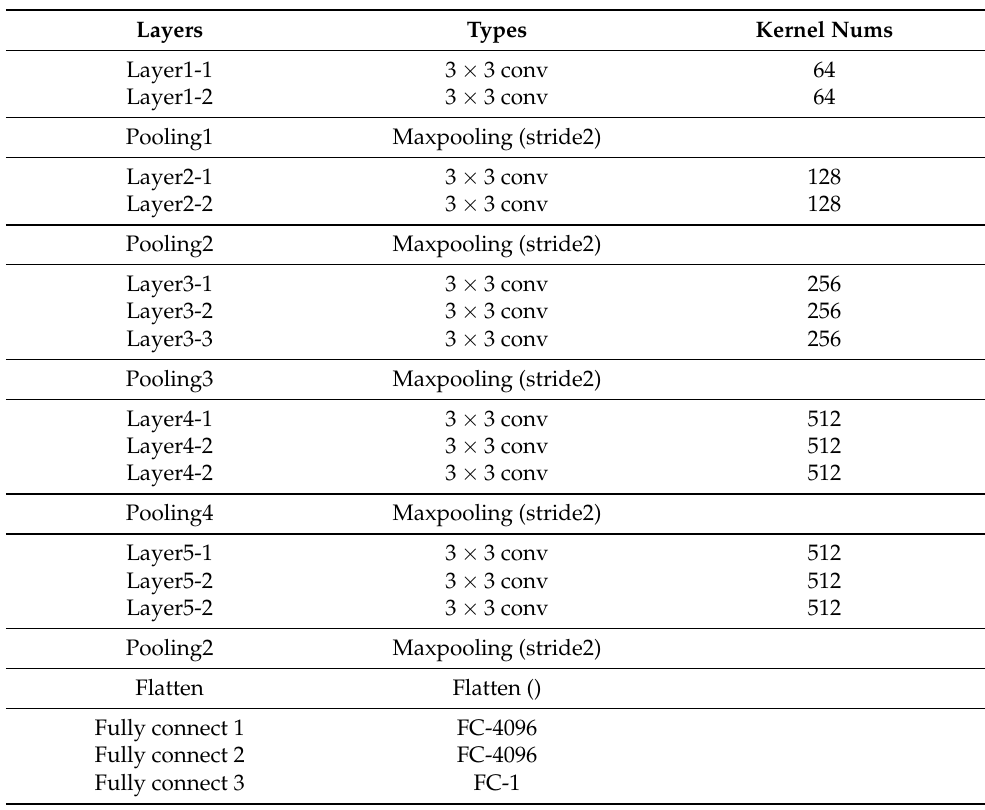
Table 1. Network